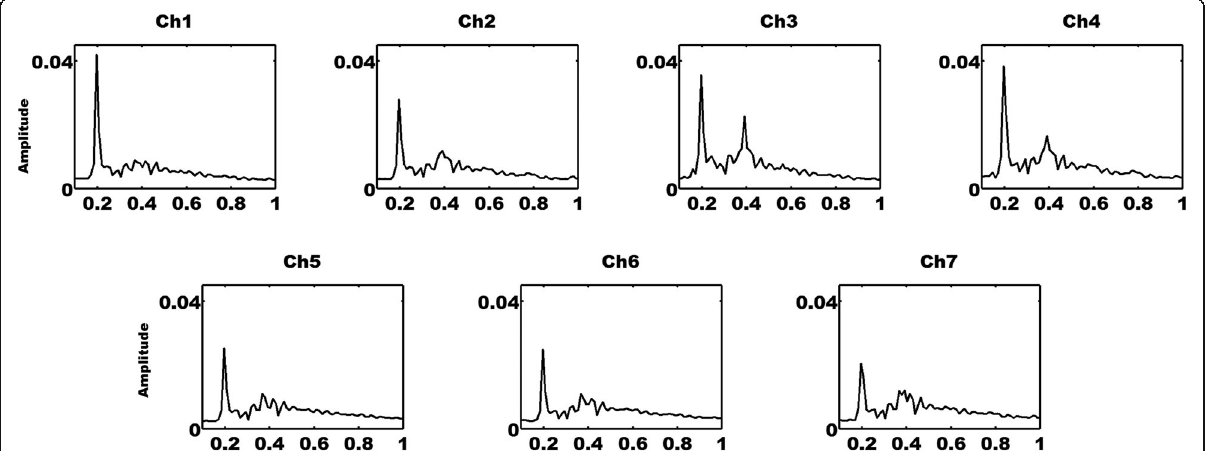
Fig. 7 The frequency domain grand-averaged LFHO signals after deconvolution across all conditions and participants during SSVEP-inducing periodic FE stimuli presentation. The unit of the x -axis is Hz while the y -axis has no units